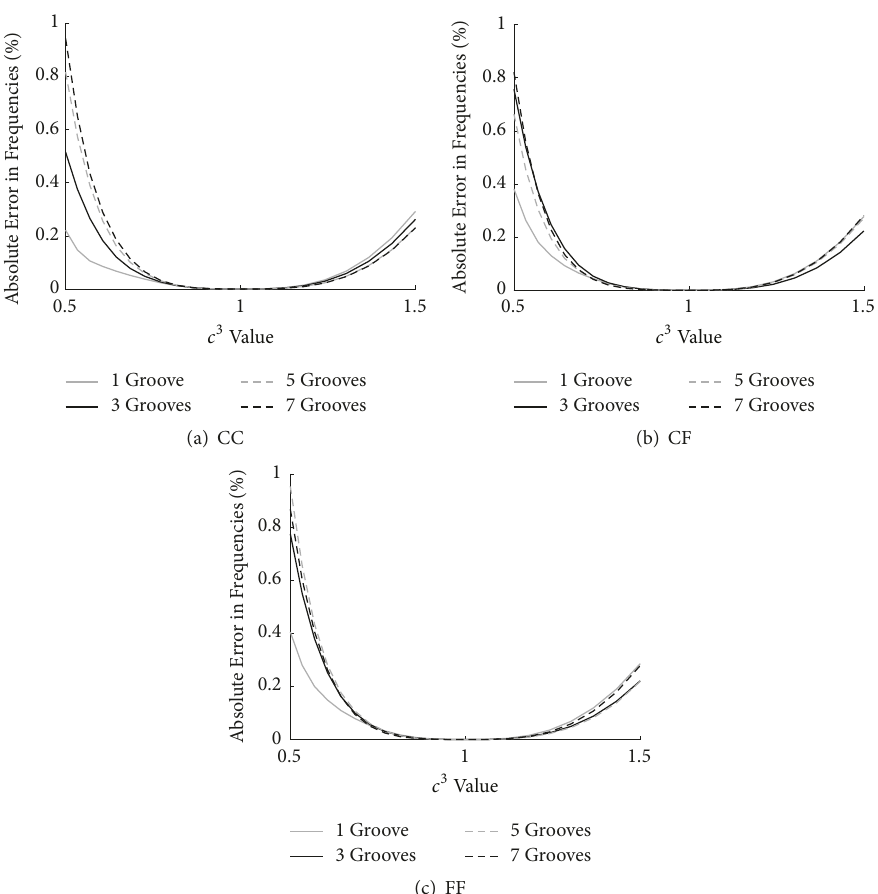
Figure 11: Frequency error results for variable 𝑐 using the norm minimization of the